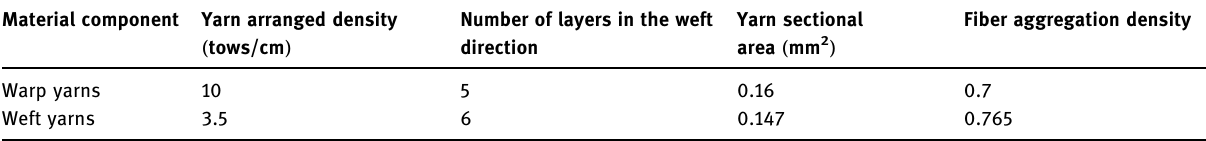
Material component Yarn arranged density ( tows/cm